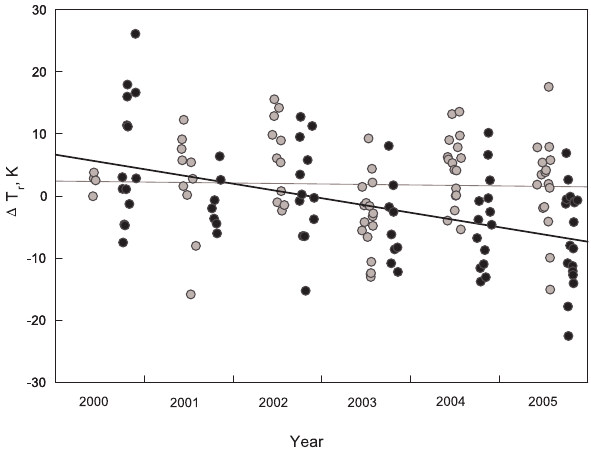
Fig. 4. Deviations ( 1 T r ) of the midnight hydroxyl temperature from the standard annual variations, presented in Table 1, and re- gression lines for the periods of June–July (grey circles and line) and October–November (black circles and